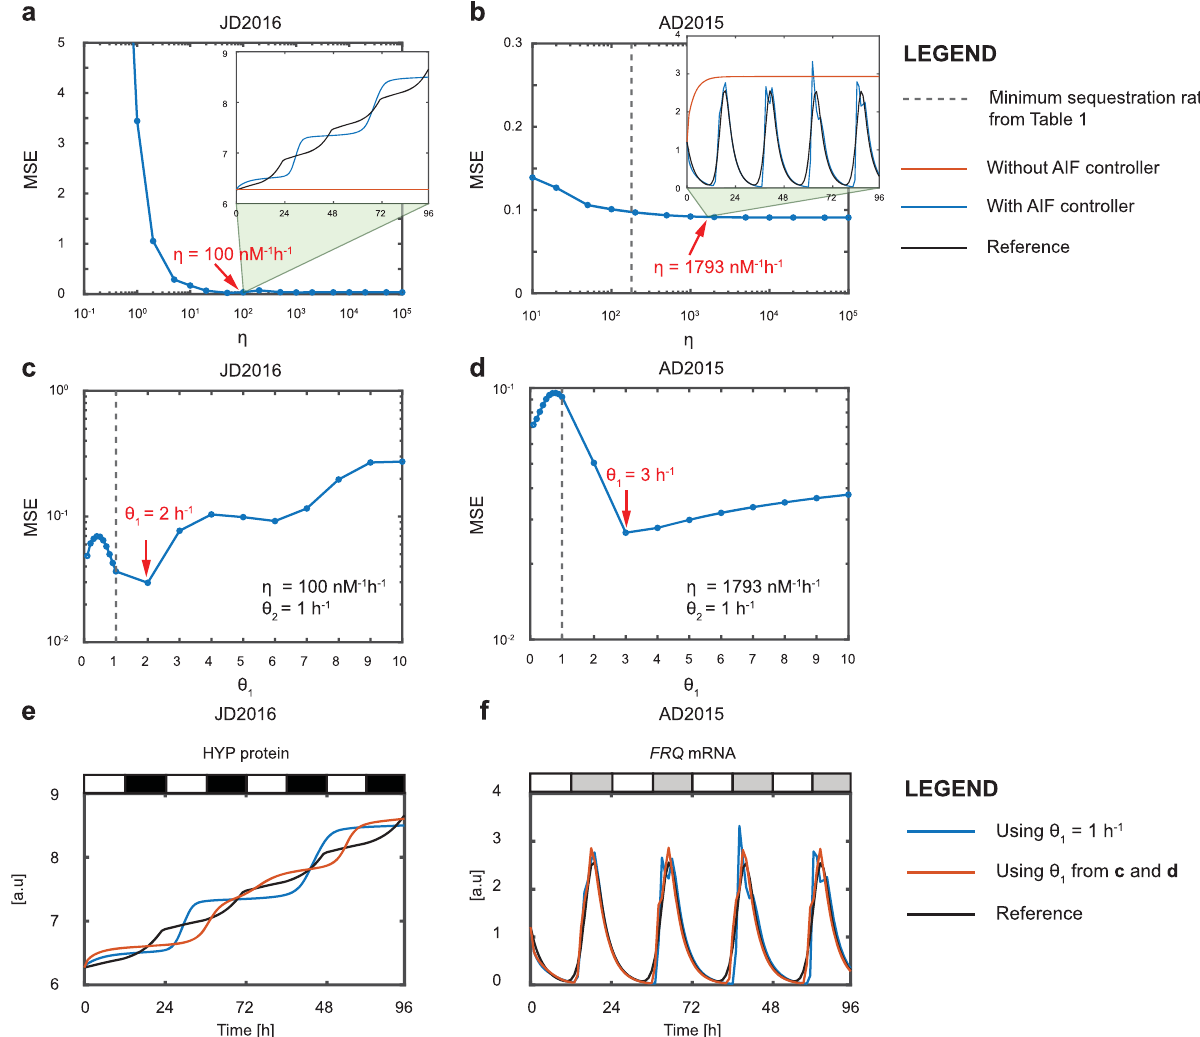
Fig. 3 Effect of varying AIF controller parameters when controller degradation is zero. a , c , e Plant clock, JD2016. b , d , f Fungal clock, AD2015. a , b Effect of varying sequestration rate η on the MSE. The inset fi gures in a , b show the time series pro fi les for the reference pro fi le and process output, with and without the use of the AIF controller. c , d Effect of varying θ 1 on the MSE. e , f Time series pro fi les obtained using the AIF controller with different values of θ 1 .